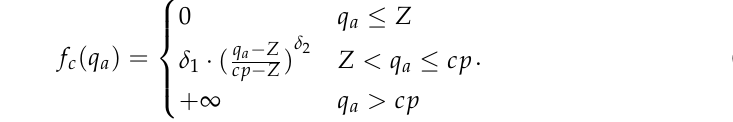
Table 2. Cont. Symbol Definition Fare per kilometer of state train. Fare per kilometer of suburban train. Distance of the running arc a .